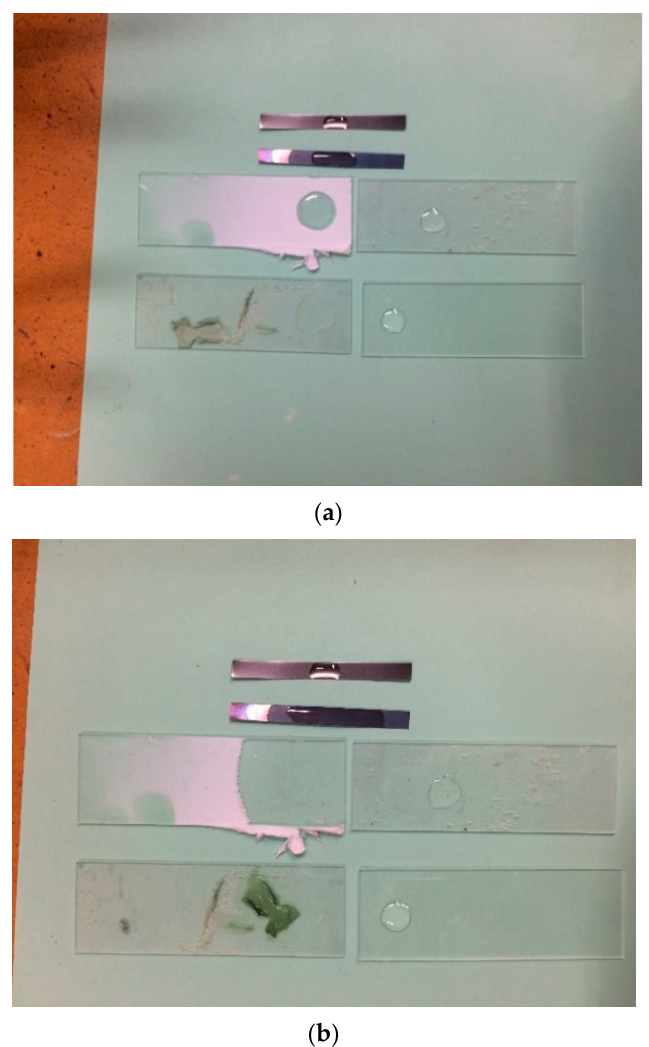
Figure 6. Photos of oil drops on glass slides after 10 min exposure to sunlight ( a ) and after 20 min exposure ( b ).